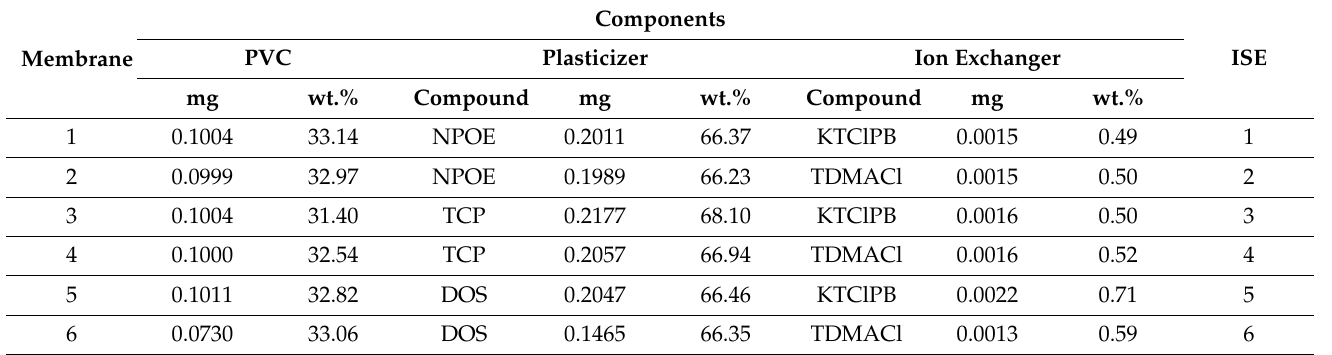
Table 1. Detailed membrane compositions and ion-selective electrodes (ISEs)